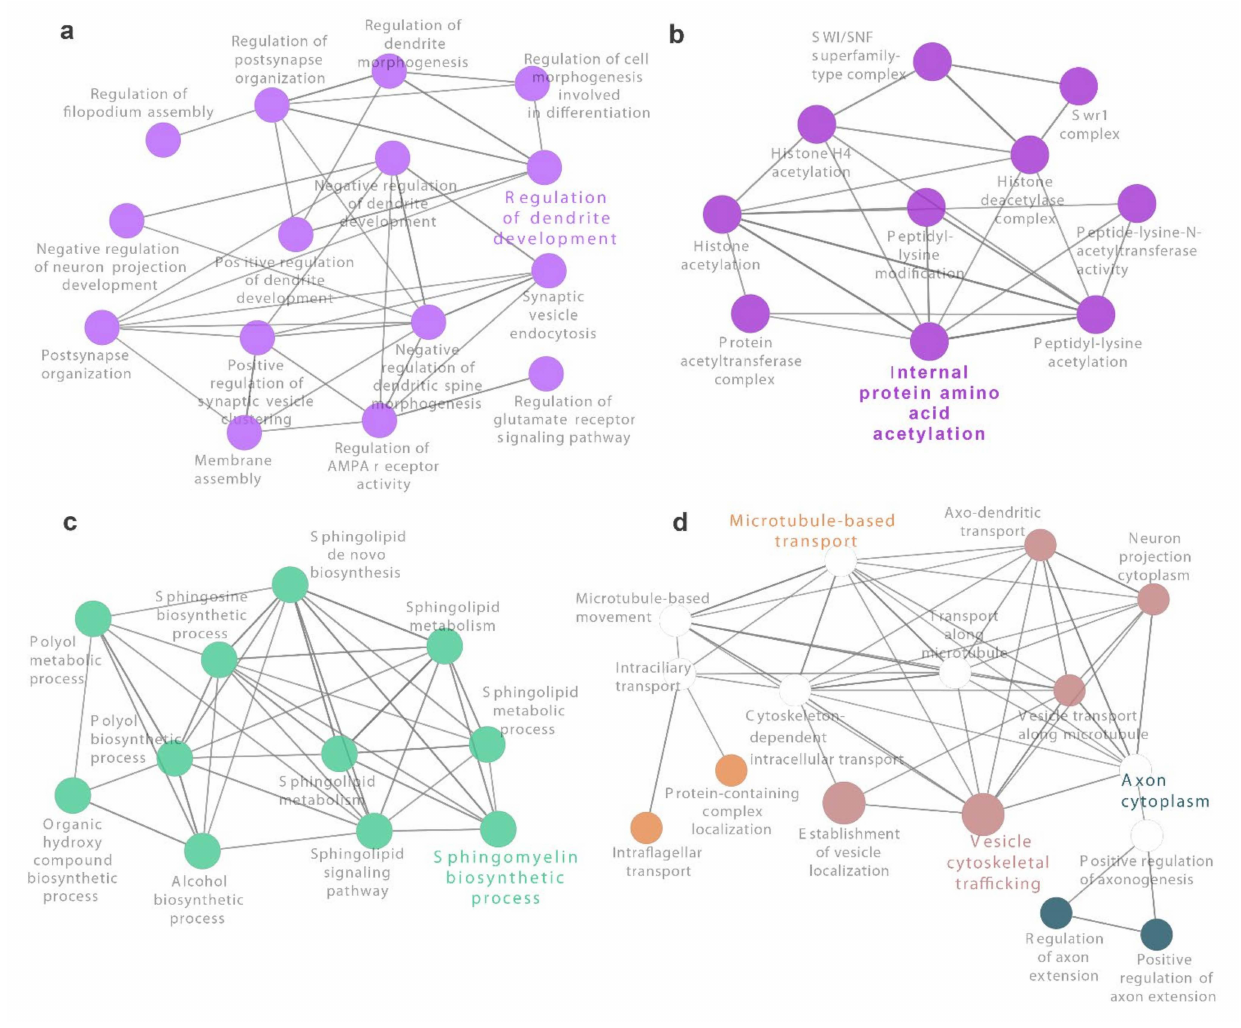
Figure 5. Main clusters of overrepresented biological pathways and terms from KEGG and Reactome knowledgebases. A total of 56 groups were identified with ClueGO Cytoscape plug-in from 152 enriched terms. Four out of the 56 groups are visualized. These correspond to clusters with 10 or more components. For each group, the most significant term is highlighted. ( a ) Regulation of dendrite development. ( b ) Internal protein amino acid acetylation. ( c ) Sphingomyelin biosynthetic process. ( d ) Microtubule-based transport, axon cytoplasm and vesicle cytoskeletal trafficking. Circle size is inversely proportional to obtained adjusted p